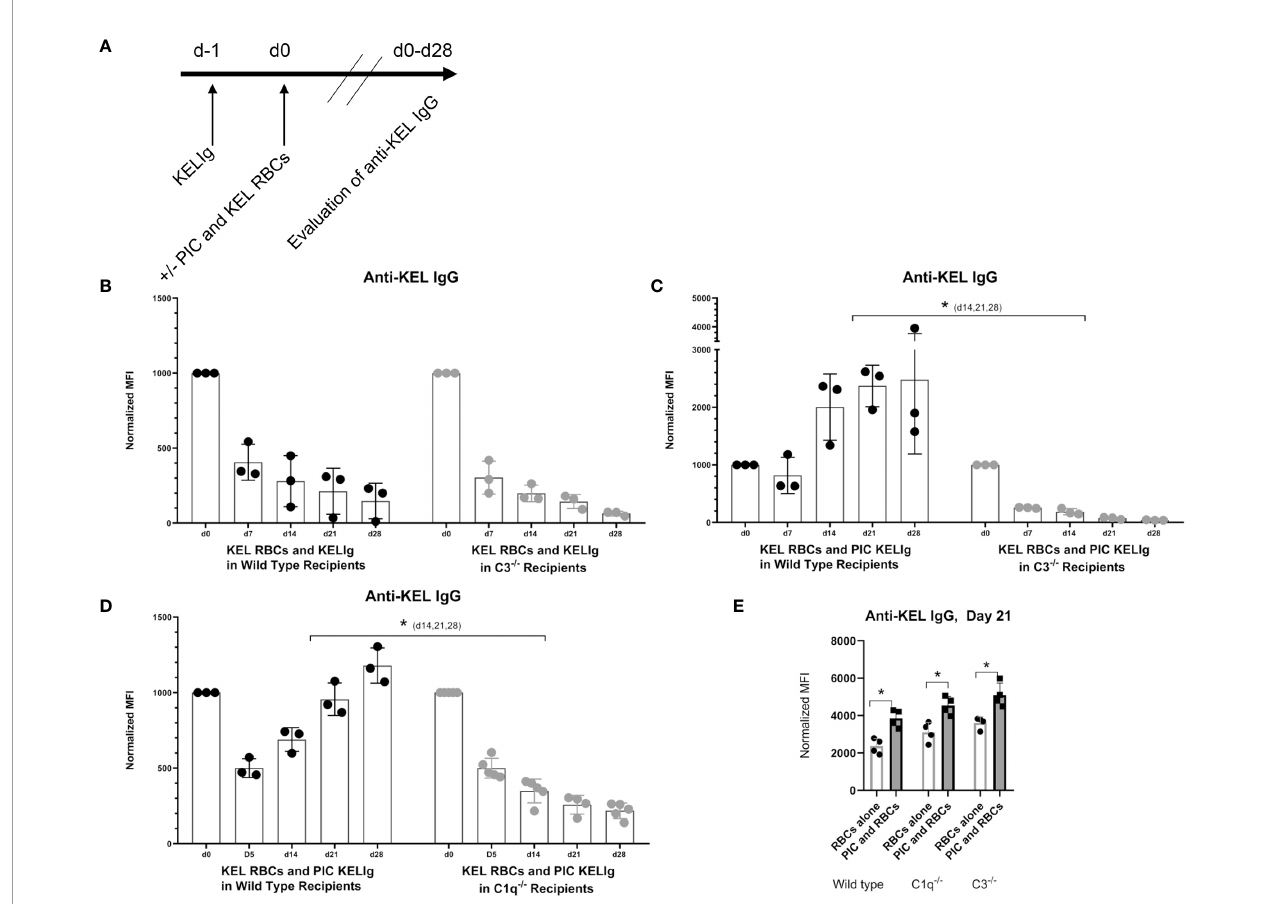
FIGURE 2 | Recipient C3 and C1q contribute to KELIg immunoprophylaxis failure in the setting of poly (I:C). (A) General in-vivo experimental design: recipients were infused with KELIg and transfused the following day in the absence or presence of poly (I:C) treatment, with anti-KEL responses evaluated longitudinally. (B) Anti-KEL IgG responses in wild type compared with C3 -/- recipients transfused in the absence of poly (I:C). (C) Anti-KEL IgG responses in wild type compared with C3 -/- recipients transfused in the presence of poly (I:C). (D) Anti-KEL IgG responses in wild type compared with C1q -/- recipients transfused in the presence of poly (I:C). (E) Baseline impact of recipient treatment with poly (I:C) on alloimmune responses to KEL RBCs in the absence of KELIg. These data are representative of 2-3 independent experiments, with 3-5 mice/group/experiment; error bars indicate standard deviation between individual mice. *p < 0.05 (C, D) d14,21,28, and all comparisons for (E)